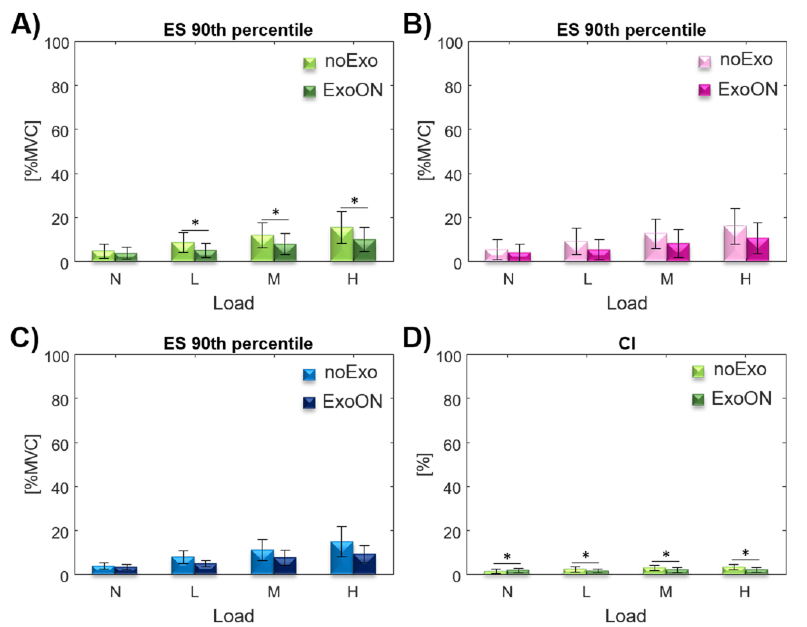
Figure 4. 90th percentile of the ES muscular activation, with and without the exoskeleton, at 0 ◦ inclination and four load conditions for the whole population ( A ), for female ( B ), and male ( C ) populations. ( D ) CI, with and without the exoskeleton, in the four load conditions.